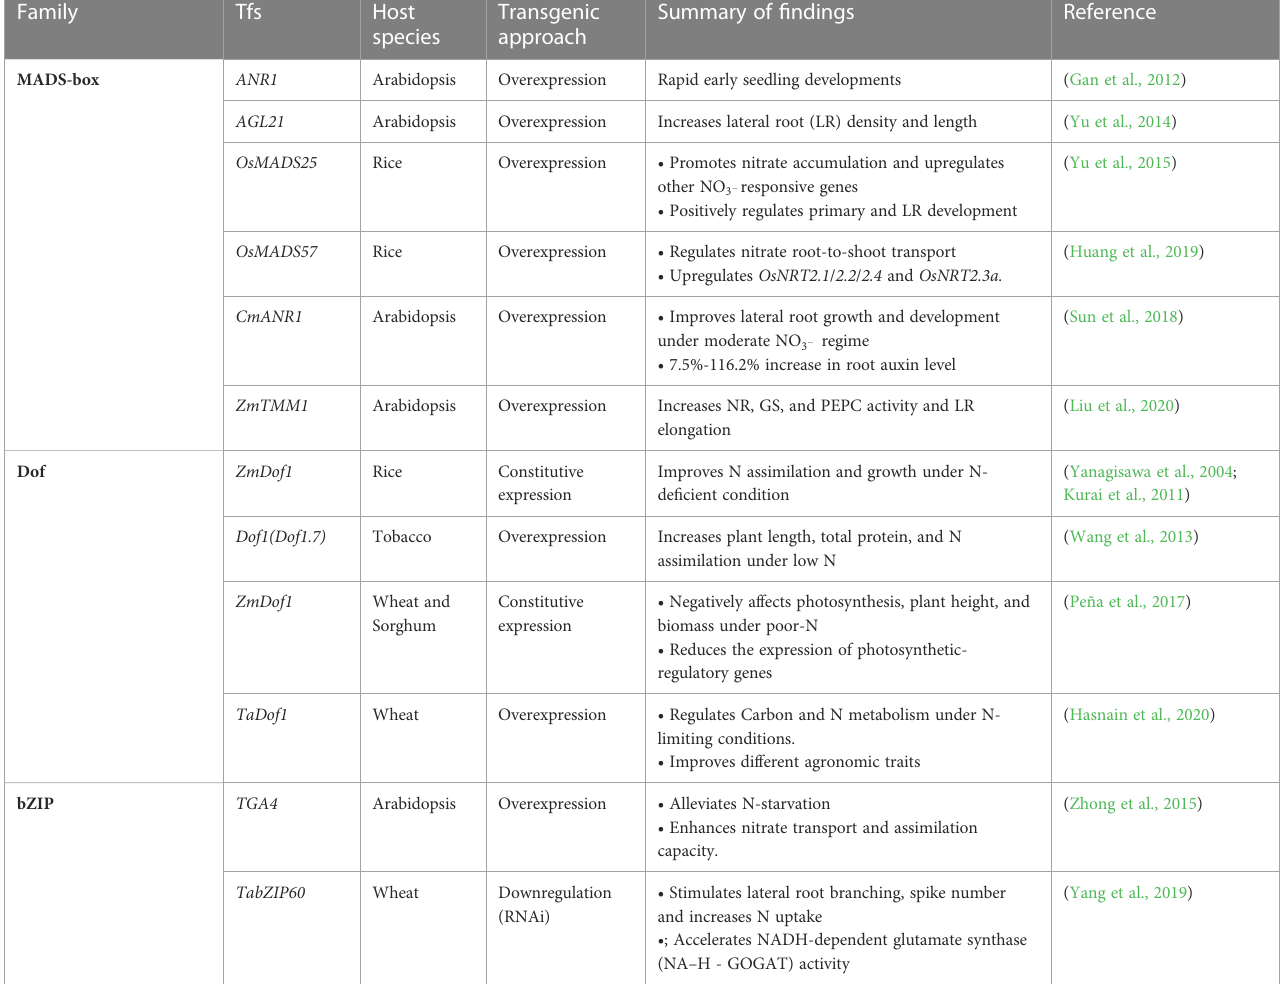
TABLE 2 Transcription factors (Tfs) involved plant nitrogen use ef fi